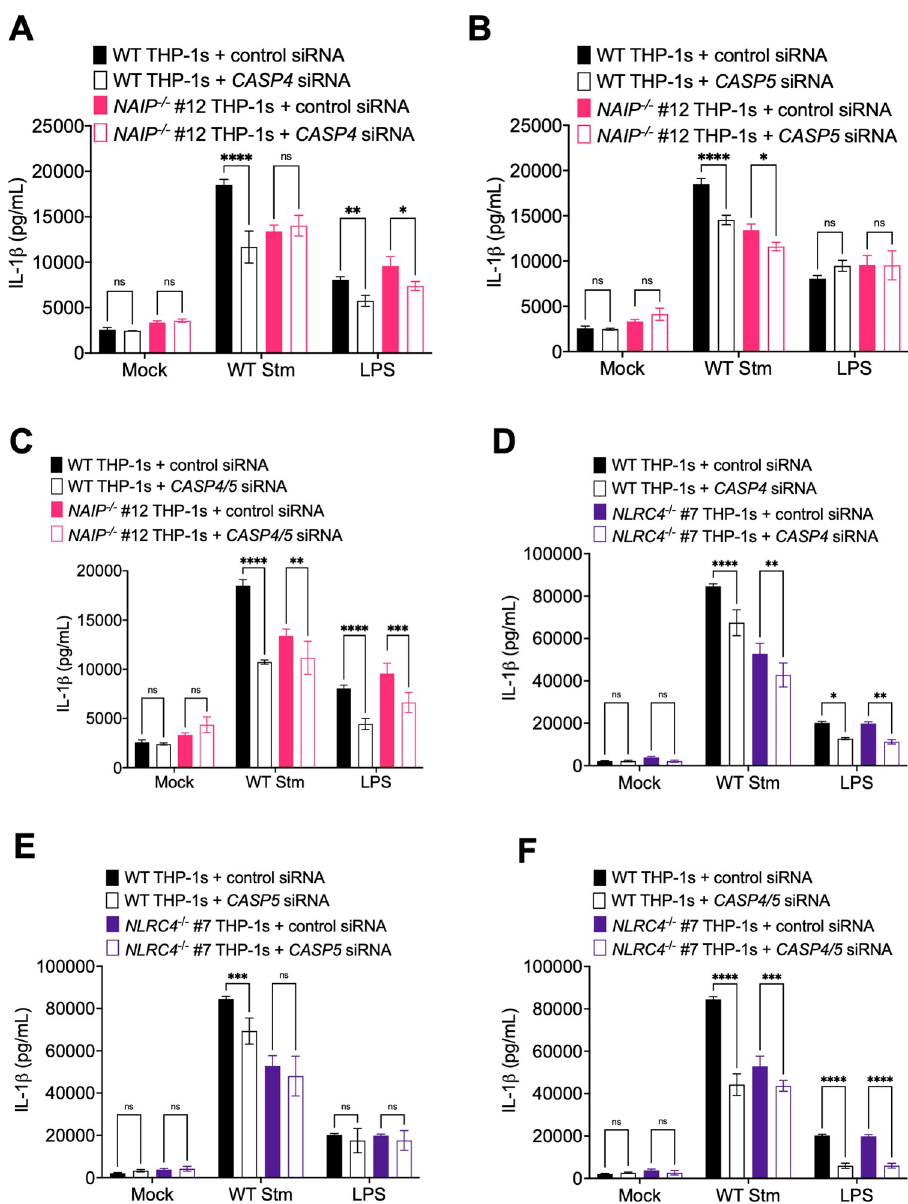
Fig 4. Salmonella induces NAIP/NLRC4- and CASP4/5-dependent inflammasome activation in human macrophages. WT, NAIP -/- (A–C) and NLRC4 -/- (D–F) THP-1 monocyte-derived macrophages were treated with siRNA targeting a control scrambled siRNA, siRNA targeting CASP4 (A, D) or CASP5 (B, E), or siRNA targeting both CASP4 and CASP5 (C, F) for 48 hours. Cells were primed with 100 ng/mL Pam3CSK4 for 16 hours. Cells were then infected with PBS (Mock) or WT S . Typhimurium at an MOI = 20 for 6 hours. Release of IL-1 β into the supernatant was measured by ELISA. As a control, cells were transfected with LPS. ns–not significant, � p < 0.05, �� p < 0.01, ��� p < 0.001, ���� p < 0.0001 by Tukey’s multiple comparisons test. Error bars represent the standard deviation of triplicate wells from one experiment. Data shown are representative of at least three independent